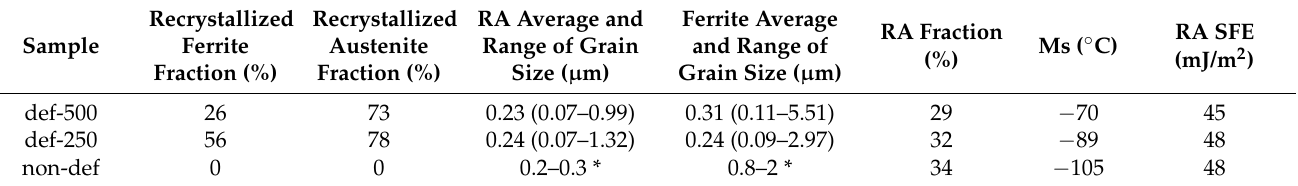
Table 2. Microstructural characteristics of the present steel after deformation at 500 ◦ C (def-500) and 250 ◦ C (def-250) and without deformation (non-def) followed by annealing at 650 ◦ C for 20